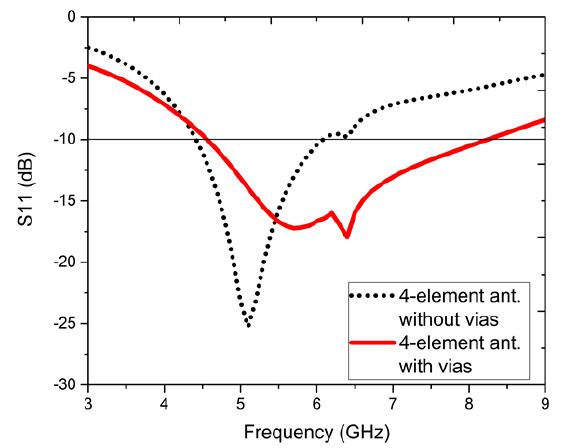
Figure 6. S11, dB parameters without and with vias for the four-element antenna